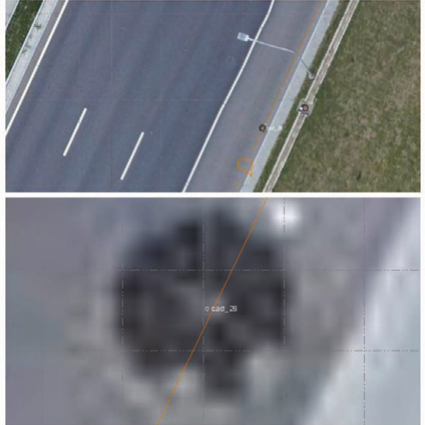
Fig. 7. Discrepancy of check point position (original and zoomed)